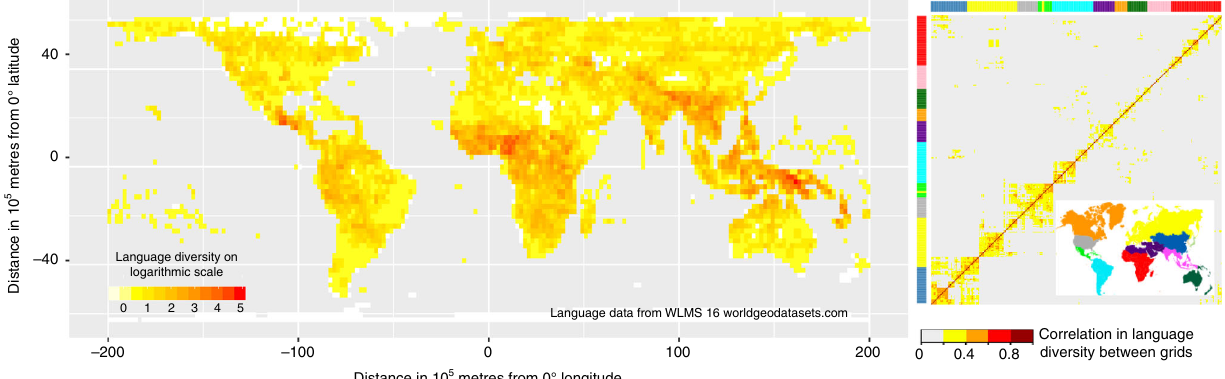
Fig. 1 Global distribution of language diversity. Left panel: values on a logarithmic scale of number of languages are shown for 200 × 200 km cells of an equal-area grid. Right panel: correlation in language diversity between each pair of grid cells owing to spatial autocorrelation and phylogenetic relatedness. Correlation coef fi cient is estimated from our generalized least squares model that includes all the climatic and landscape variables as predictors (see Methods). Correlated grid cells are roughly clustered into nine geographic regions, so we color code the rows and columns by these regions. Grid cells within East Asia, Europe, and the Americas are more autocorrelated than grid cells within the other